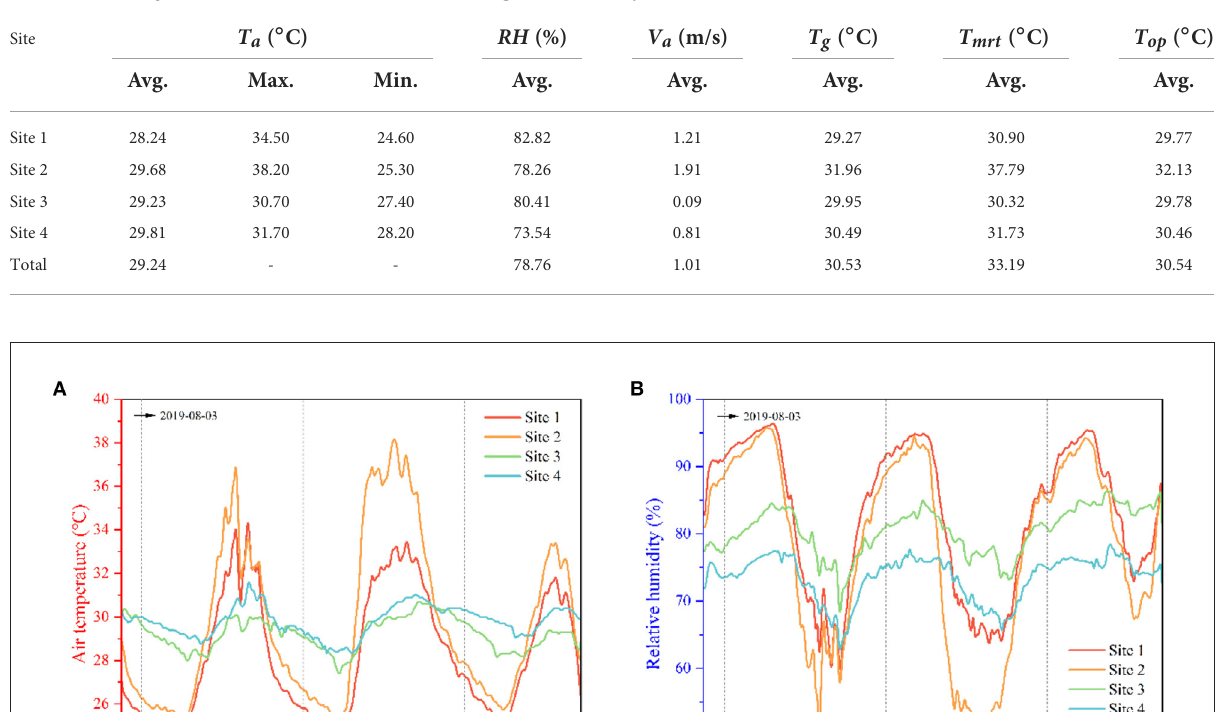
TABLE 4 Summary of the indoor thermal environment during the measured period.